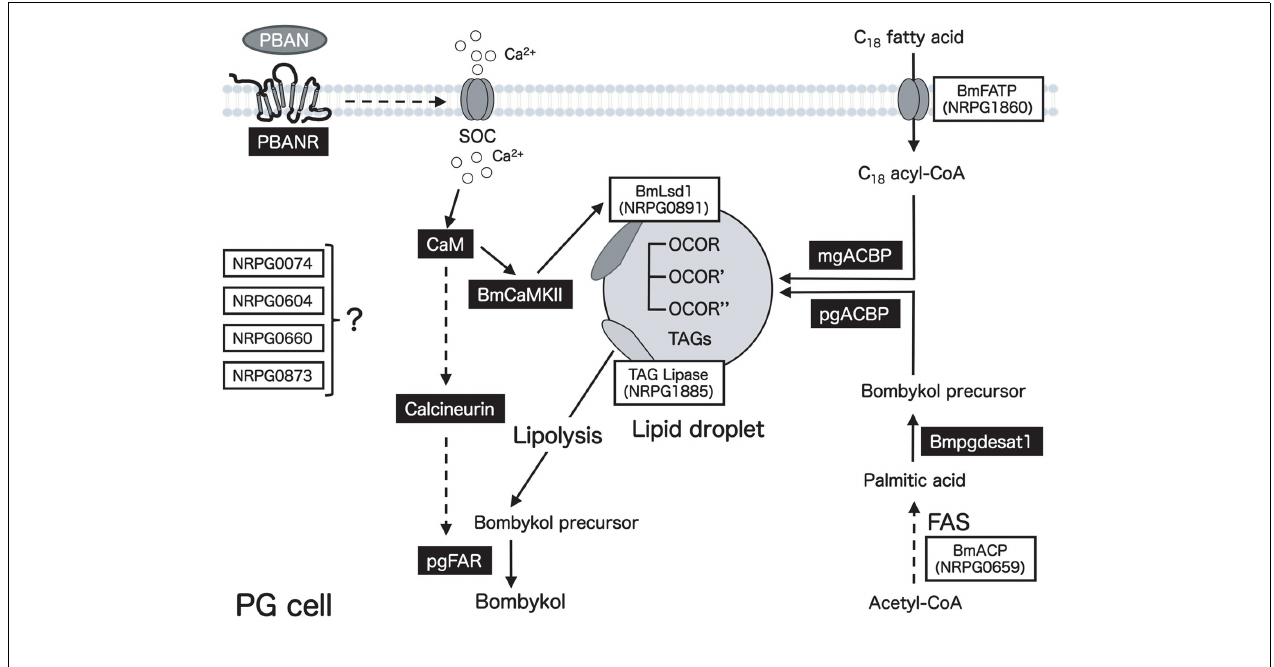
FIGURE 8 | Schematic diagram of the proposed bombykol biosynthetic pathway. Eight EST clones involved in bombykol biosynthesis are indicated in